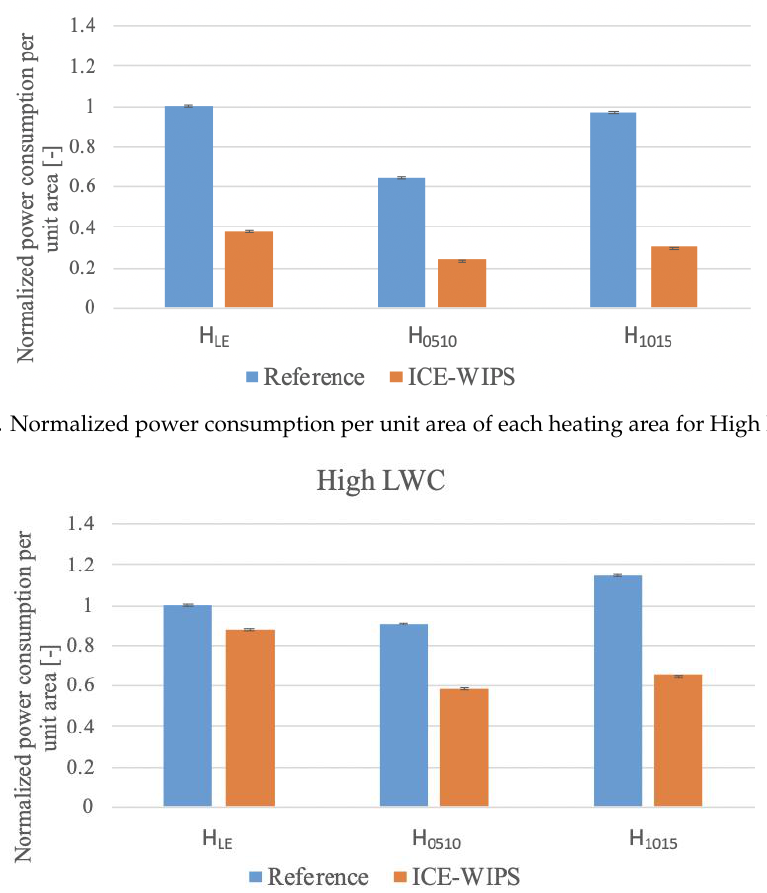
Figure 12. Normalized power consumption per unit area of each heating area for High MVD case.